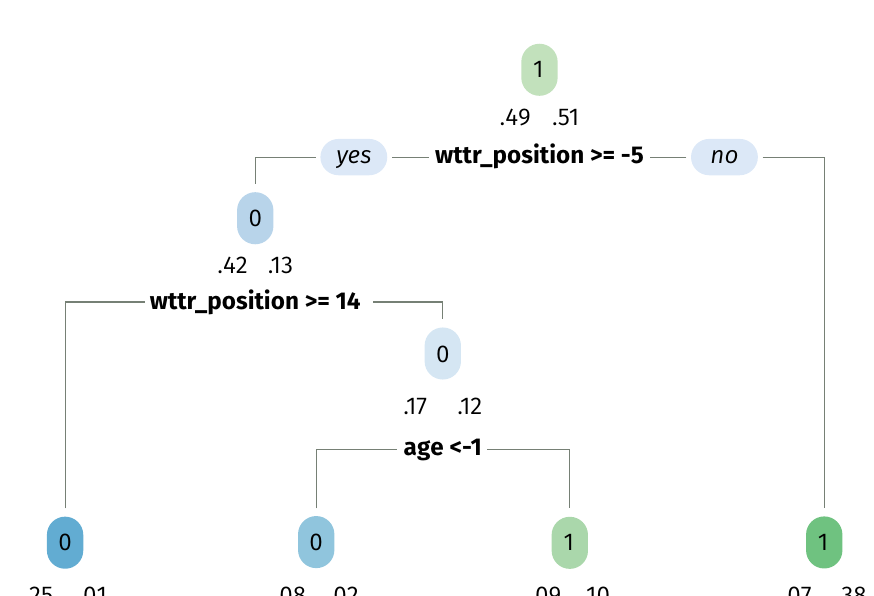
Figure 1. Overview over a simplified decision tree. Recall that the variables wttr_position (WTTR-position) and age are representing differences between the two involved players. It is visible how the probabilities for a win (1) get refined after each